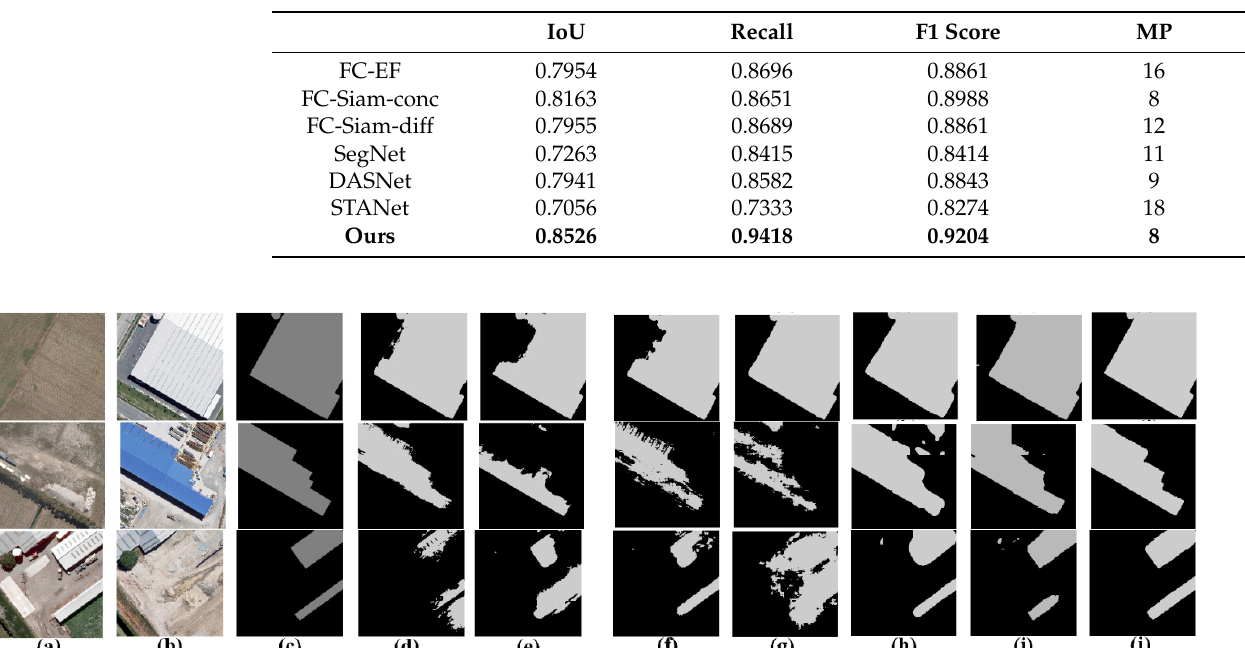
Table 4. Comparisons between MDEFNET and several typical deep learning models.